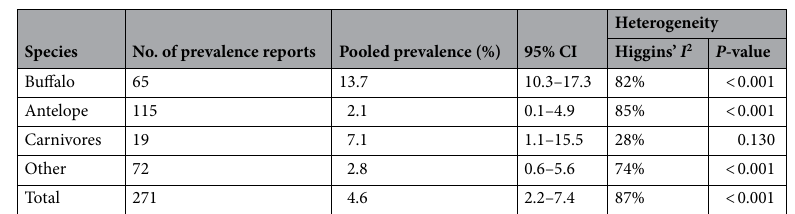
Table 5. Pooled prevalence and heterogeneity estimates in a meta-analysis of prevalence of brucellosis in African wildlife species.